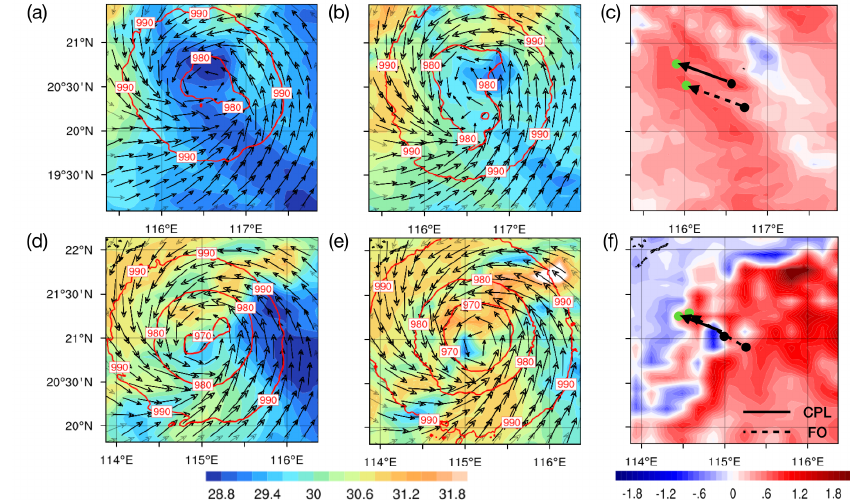
Figure 5. The horizontal plane of SST and atmospheric parameters at 1400 UTC and 2100 UTC on 22 August. ( a ) SST (shade, ◦ C), SLP (contours with the interval of 10 hPa) and 10-m high wind speed (vector) at 1400 UTC 22 August in CPL experiment. Panel ( b ) is same as panel (a) but in FO experiment. ( c ) is the SST difference between the FO and CPL experiment (FO minus CPL), on which the black dot with solid arrow shows the CPL storm center and moving direction at 1400 UTC while the one with dotted arrow is for the FO storm simultaneously. The green dots indicate the storm centers 3 h later during both simulations. Panels ( d – f ) are same as panels ( a – c ) but for the 2100 UTC on 22 August,